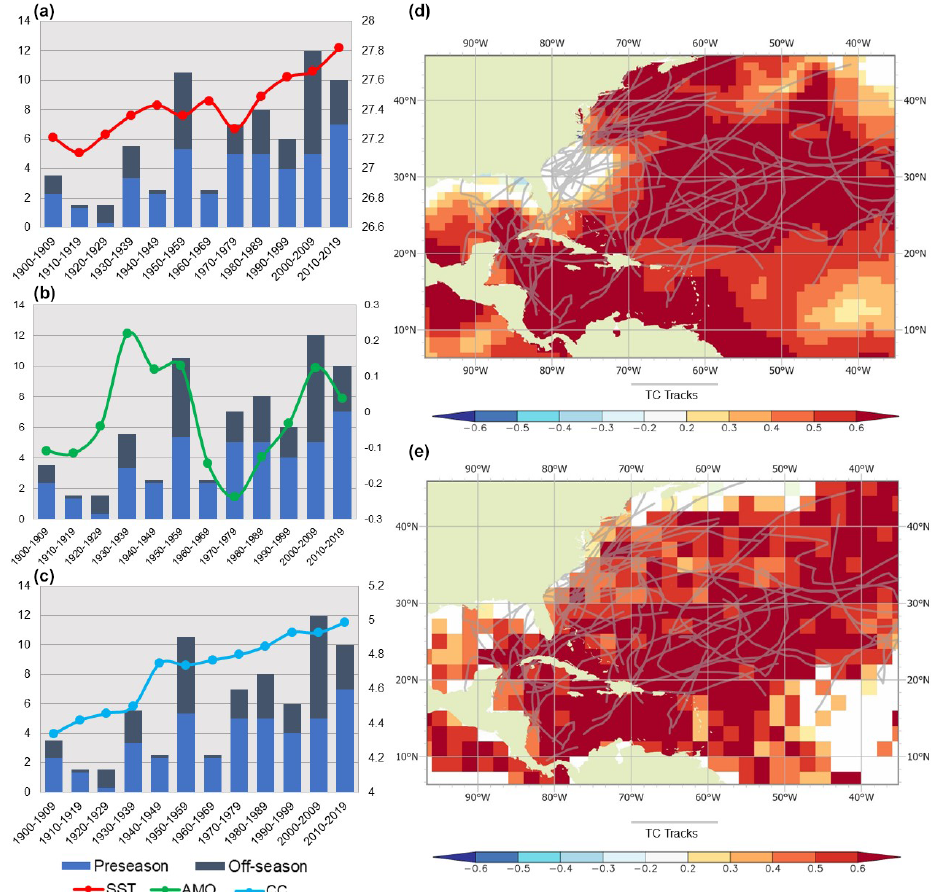
Figure 4. Decadal TC counts for the NA off-seasons and decadal average SSTs (a) ; decadal TC counts for the NA off-seasons and decadal average AMO (b) ; decadal TC counts for the NA off-seasons and decadal average correlation between time and December–May-averaged CC (c) ; correlation between time and December–May-averaged SST ( ◦ C) and the off-season TC tracks for the 1900–2019 period (d) ; and correlation between time and December–May-averaged CC (oktas) and the off-season TC tracks for the 1900–2019 period (e)